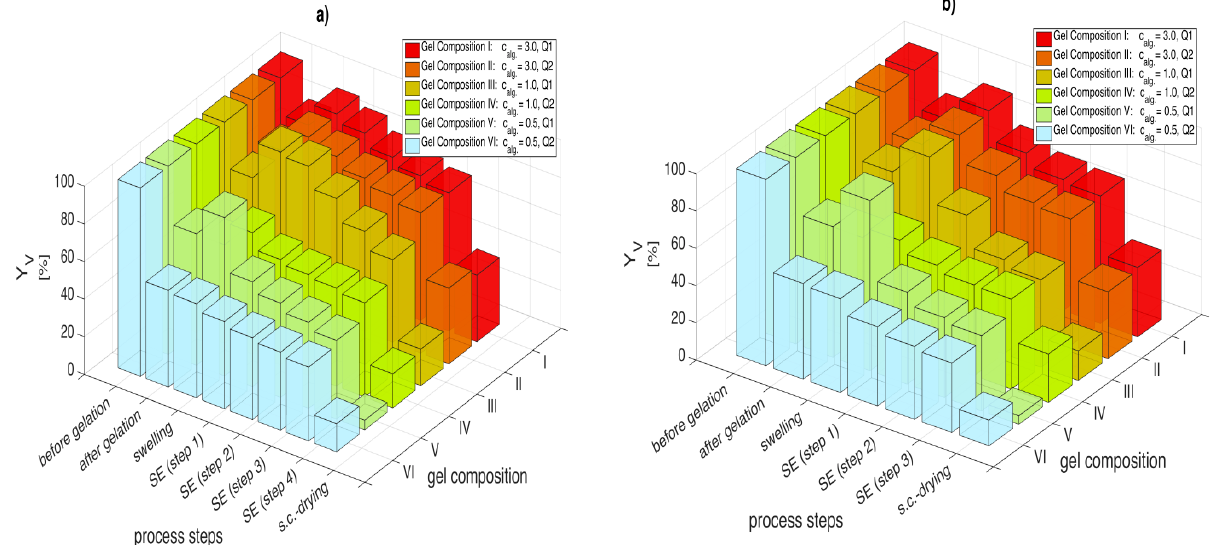
Figure 6. Volumetric yields after gelation, swelling, each process step for solvent exchange with DMSO and supercritical CO 2 drying; for ( a ) Δ c = 30 wt % and ( b ) Δ c = 50 wt